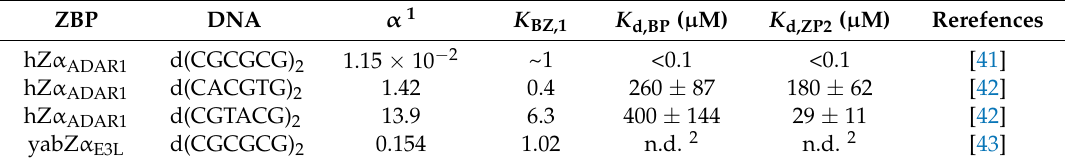
Figure 3. ( a ) Mechanism for the B-Z conformational transition of a 6-bpDNA by two ZBPs [41]. ( b ) Relative Z-DNA populations ( f Z ) of d(CGCGCG) 2 (grey circle) [41], d(CACGTG) 2 (dark green circle) [42], and d(CGTACG) 2 (brown circle) [42] induced by hZ α ADAR1 in NMR buffer (pH = 8.0) containing 100 mM NaCl as a function of [P] t /[N] t ratio. ( c ) f Z of d(CGCGCG) 2 induced by hZ α ADAR1 (grey circle) [41], yabZ α E3L (orange triangle) [43], and hZ β DAI (purple triangle) [44] in NMR buffer (pH = 8.0) containing 100 mM NaCl as a function of [P] t /[N] t ratio. ( d ) f Z of d(CGCGCG) 2 at 10 mM NaCl (blue square) and d(TCGCGCG) 2 at 10 mM (red square), 100 mM (pink square), and 250 mM NaCl (light pink square) induced by caZ α PKZ [45]. Table 1. Equilibrium constants for the ZBP-induced B-Z transition.